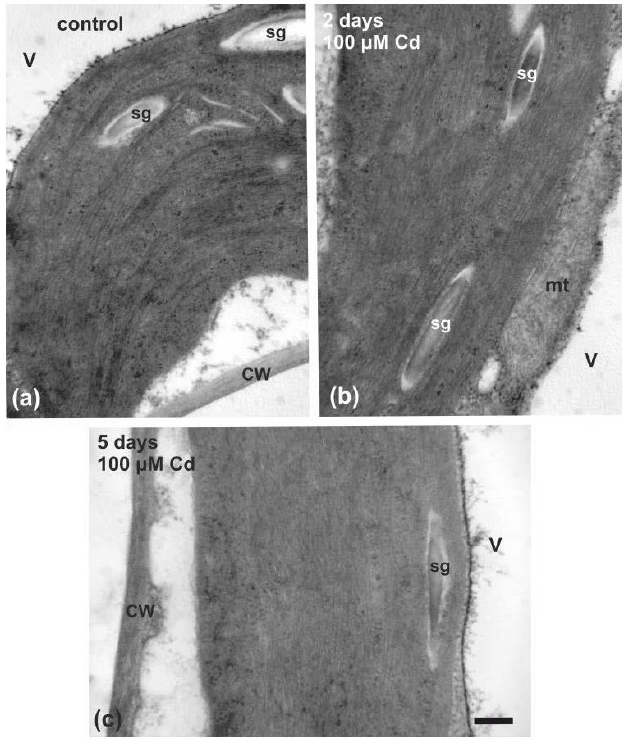
Figure 13. Transmission electron microscopy (TEM) images of control (untreated) chloroplasts ( a ) and 2 day ( b ), or 5 day ( c ), Cd-treated Salvia sclarea leaves. Chloroplasts appear electronically dense and upon Cd treatment ( b , c ), no noticeable disruption has been detected. cw: cell wall; mt: mitochondria; sg: starch grain; v: vacuole. Scale bar: 500